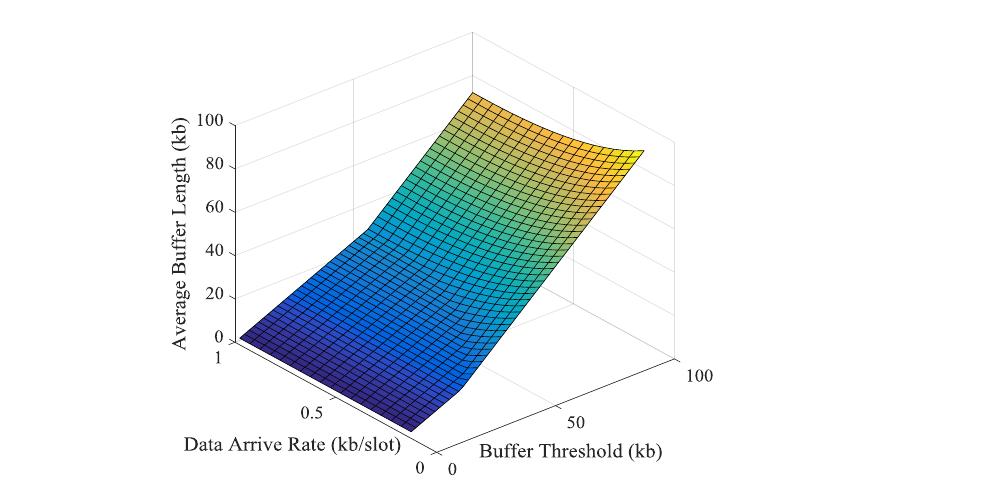
Figure 32. Theoretical results of the impact of buffer threshold and data arrival rate on the average buffer length.